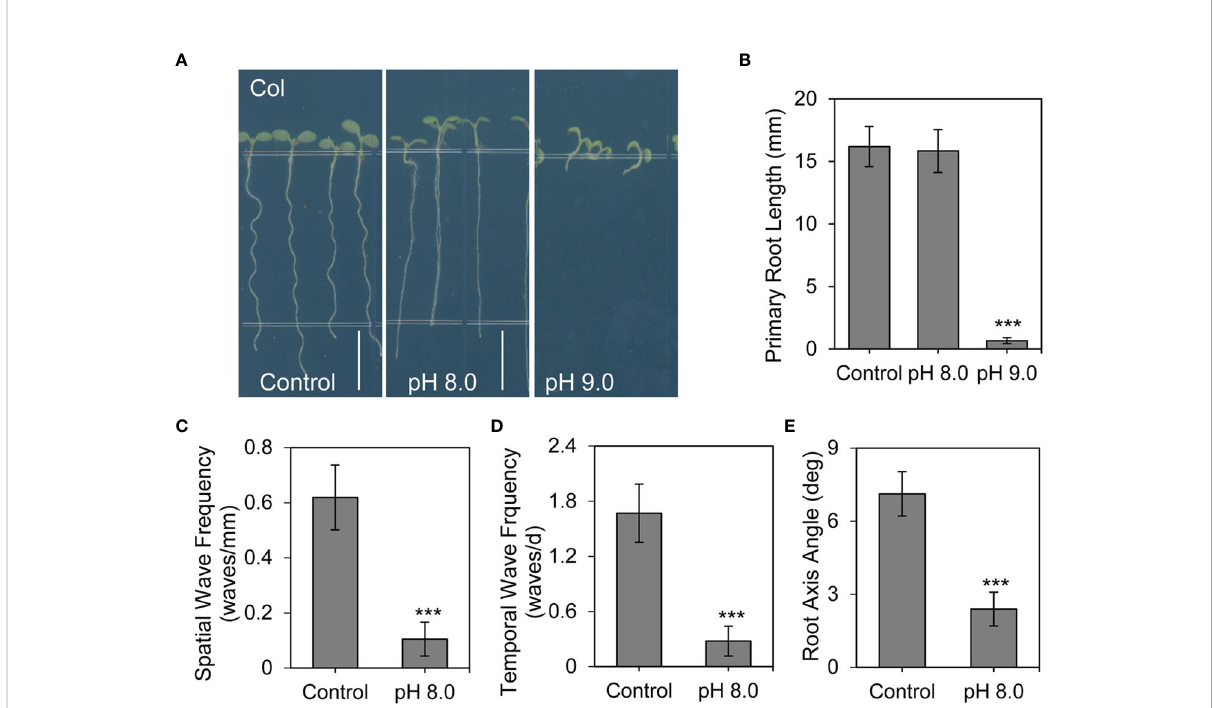
FIGURE 1 Root waving is inhibited under alkaline stress conditions. (A) Root phenotype of wild-type Arabidopsis seedlings on growth medium at pH 5.8 (control), pH 8.0, or pH 9.0 for 6 days (n > 35). Scale bar, 5 mm. (B) Quanti fi cation of the primary root length as shown in (A) Values are mean ± SD (n > 35 seedlings). (C, D, E) Statistical analysis of the spatial wave frequency (waves/mm) (C) , temporal wave frequency (waves/d) (D) , and root axis angle (E) as shown in (A) Each experiment was repeated three times (n > 35). Statistically signi fi cant differences were determined by using student ’ s t-test (***P <